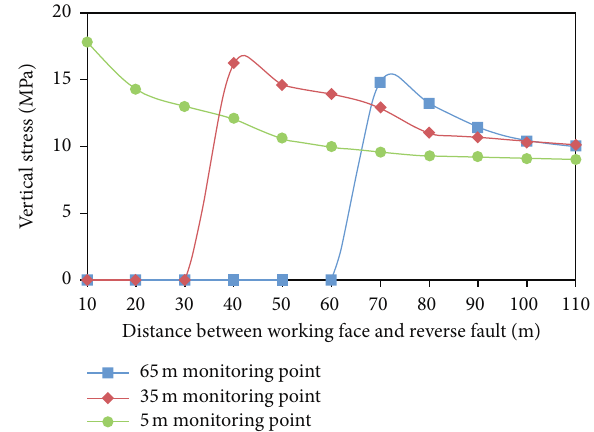
Figure 7: Variation curve of the vertical stresses at the monitoring points in footwall